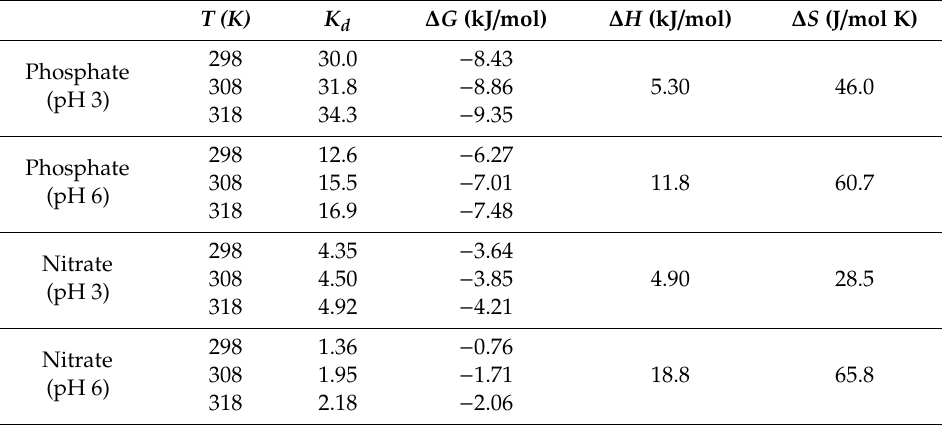
Table 5. Thermodynamic parameters for phosphate and nitrate removal by SBAC 100 MgFe composite at pH 3 and pH